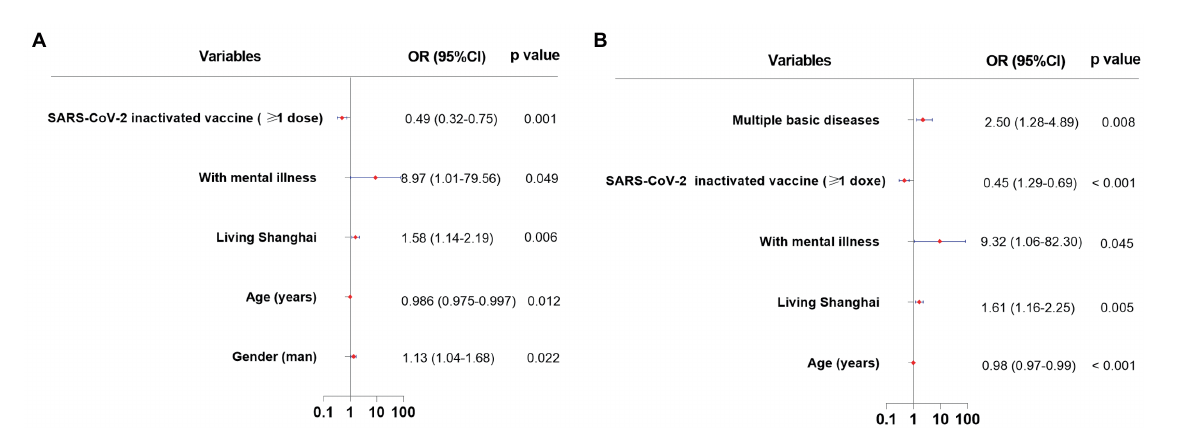
FIGURE 1 Susceptibility factors associated with anxiety and depression. (A) : susceptibility factors associated with anxiety. (B) : susceptibility factors associated with